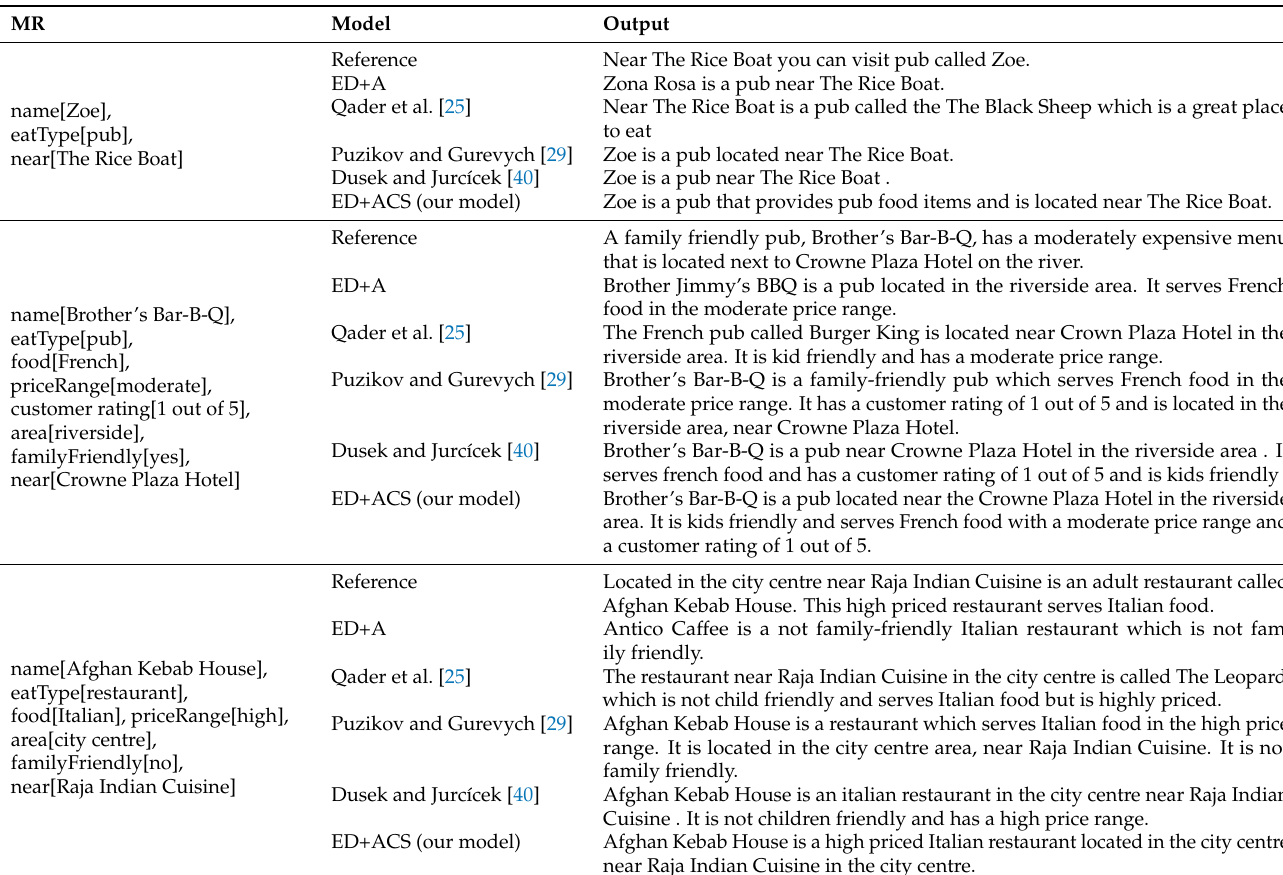
Table 5. Meaning representations, references, and model outputs on various E2E-NY test set